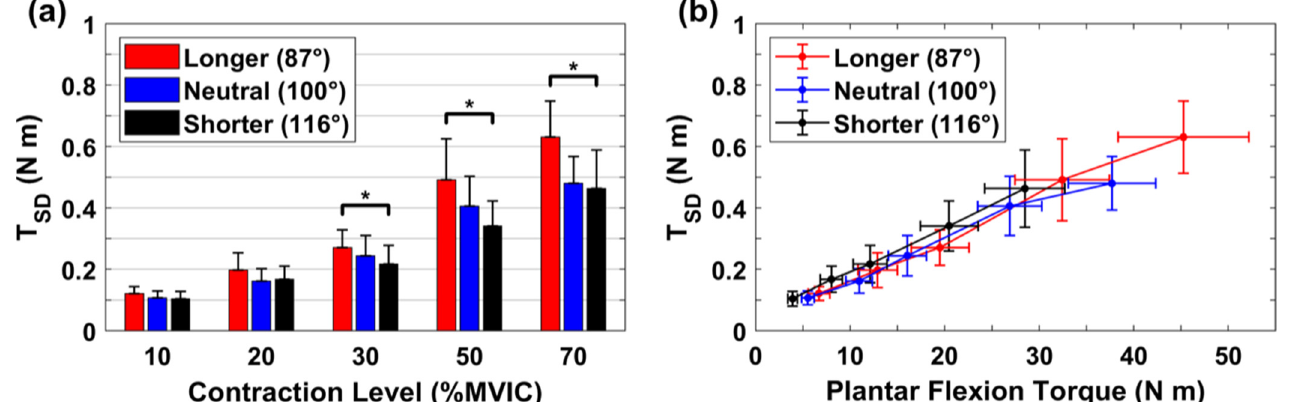
Figure 3. ( a ) Absolute torque variability at different contraction intensities and ankle joint positions. ( b ) Relationships between absolute torque variability and actual plantar flexion torque at different ankle joint positions. Asterisk indicates a significant difference (* p < 0.050) between the longer muscle length and the shorter one. T SD indicates the absolute torque variability. Error bar indicates SEM.